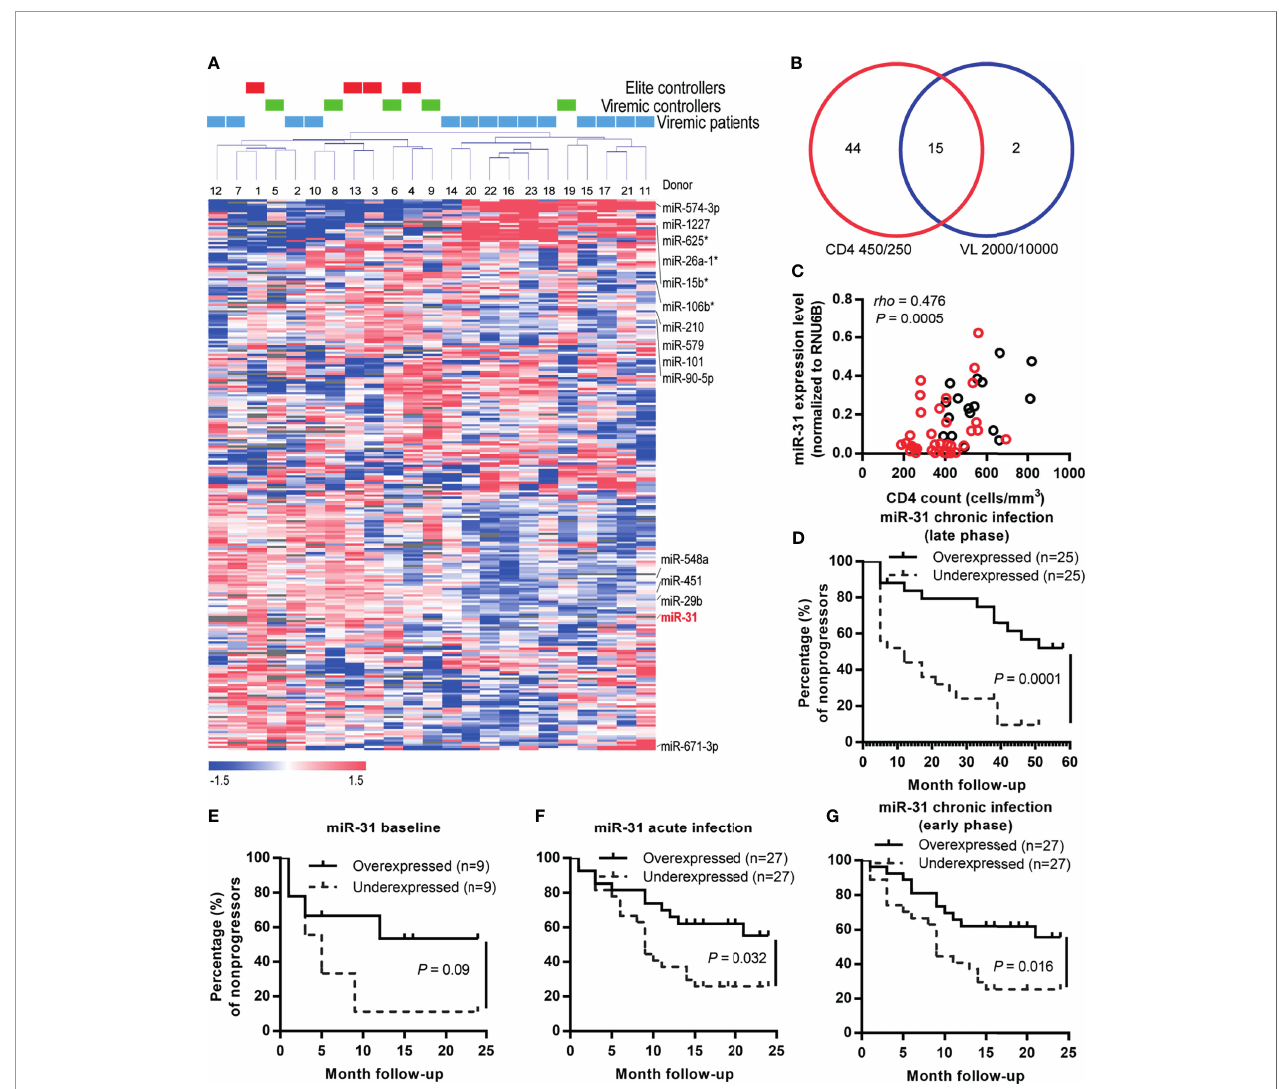
FIGURE 1 | miR-31 is correlated with disease progression during both acute and chronic HIV-1 infection. (A) Unsupervised clustering of the 251 miRNAs. After normalization and fi ltering of the microarray data, 251 miRNAs were retained for further analysis. Average linkage hierarchical clustering was performed using a centered correlation metric. Twenty-three samples from the FBD study were clustered into 2 groups: the left cluster was a mixture of elite controllers, viremic controllers and progressors; the right was mainly progressors with one exception. (B) Venn diagram showing the numbers of candidate miRNAs fi ltered with different criteria. The miRNAs in the lower left and right circles were generated by signi fi cance analysis of microarrays (SAM) of participants strati fi ed by the CD4+ T cell count (<250 cells/ m L vs. >450 cells/ m L) and viral load (<2000 copies/mL vs. >10000 copies/mL), respectively. The identi fi ed 15 miRNA candidates were marked in red in (A) . (C) Correlation between expression levels of miR-31 and CD4+ T cell counts in HIV-1 infected individuals (FBD, former blood donor cohort). miR-31 expression was quanti fi ed by quantitative RT-PCR, and the relationship between relative level of miR-31 and CD4+ T cell count was examined by Spearman correlation (n = 50). Red dots represent patients that eventually reached the de fi ned endpoints. (D) Kaplan-Meier survival curves of FDB patients strati fi ed by median whole blood miR-31 level during the late phase of chronic infection. (E – G) Kaplan-Meier survival curves of another HIV patient cohort (an acute-phase prospective men who have sex with men (MSM) cohort) strati fi ed by plasma miR-31 levels before and after infection. Absolute CD4+ T cell count below 350 cells/ m L, initiation of long-term ART, progression to AIDS and death were de fi ned as endpoints of the study. Patients were separated into two groups strati fi ed by the median miR-31 level in plasma collected before infection (E) , during acute infection phase (F) , during early phase of chronic infection (G)